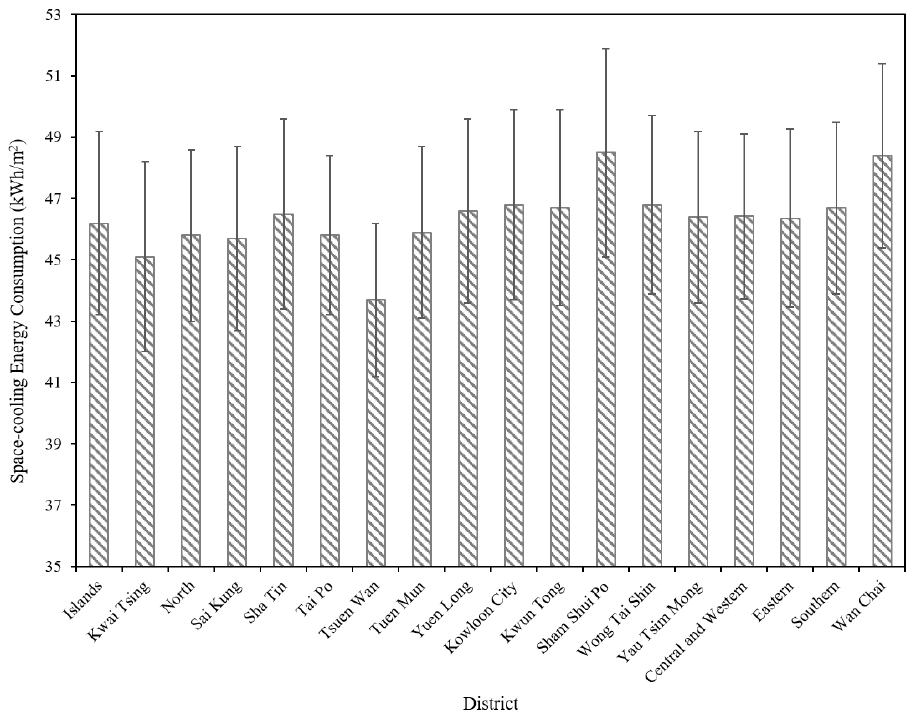
Figure 5. Space-cooling energy consumption for different archetypes (a: ground-floor flats, b: middle-floor flats, and c: top-floor flats) with the pensioner/family occupancy. The error bars indicate ±1 standard deviation.